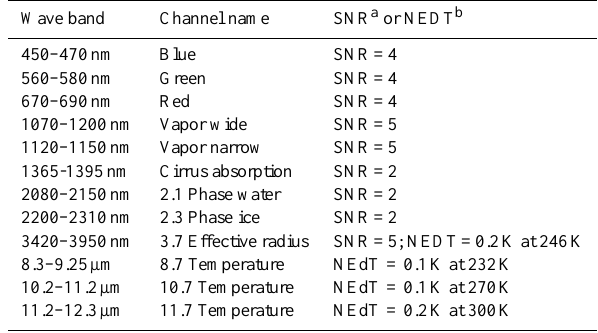
Table 1. The spectral bands of the Multi-Spectral Imager, which will have a footprint of